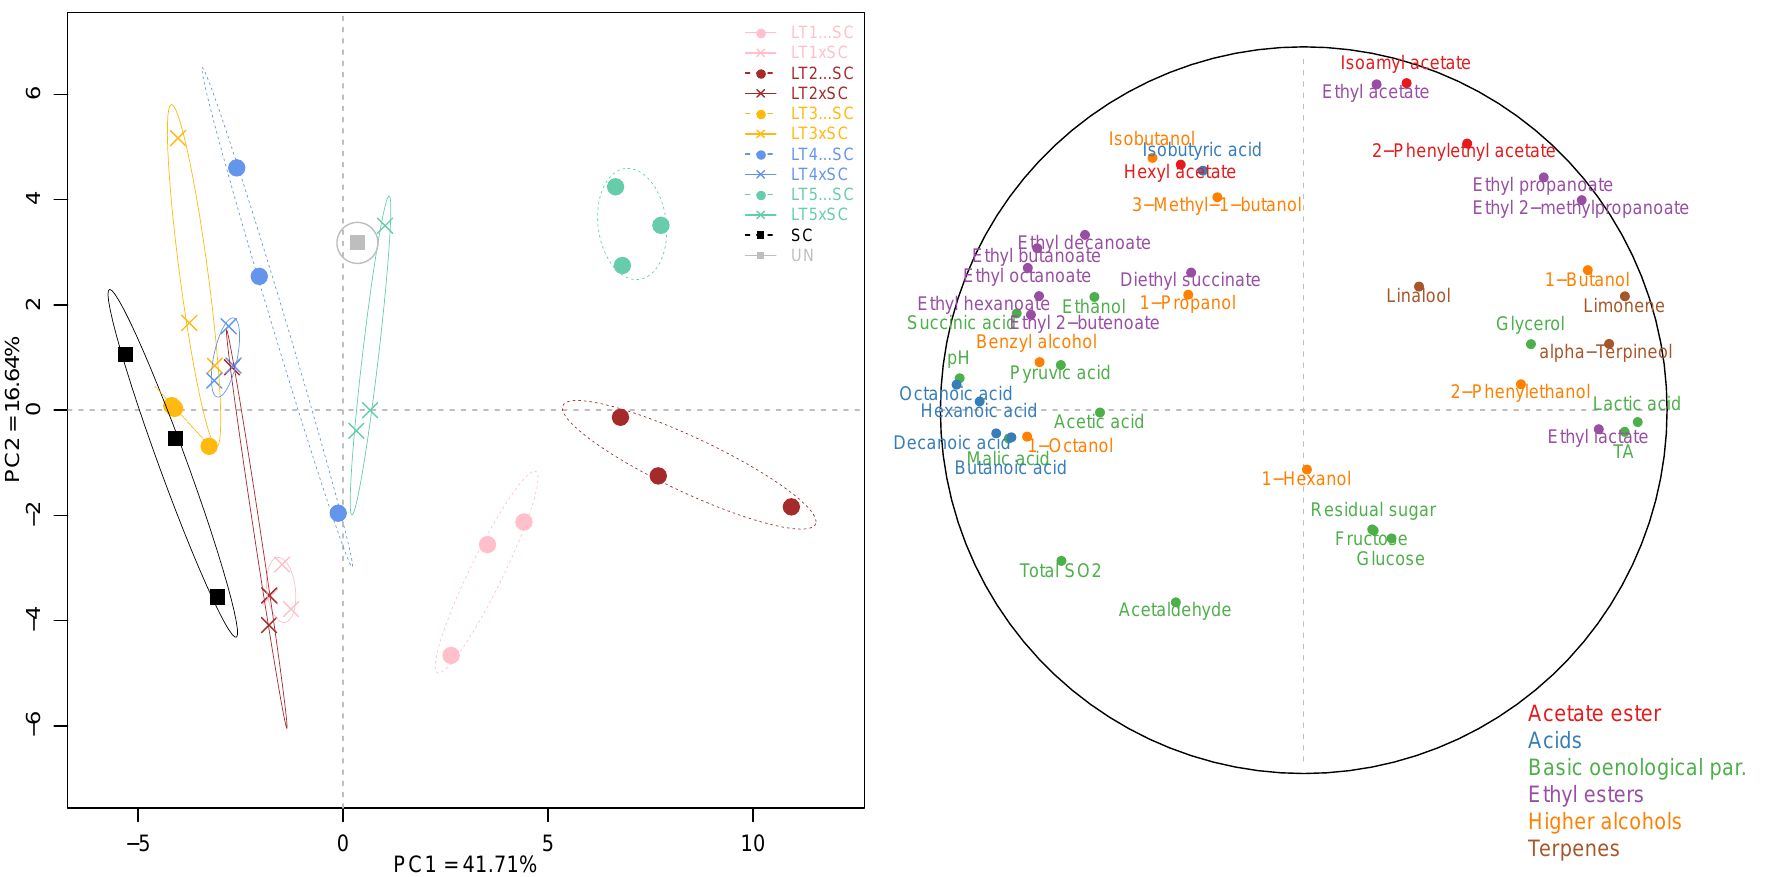
Figure 4. Principal component analysis of 43 chemical parameters in the experimental Viognier wines: yeast treatments ( left ) and correlation circle ( right ). The abbreviations and colour-coding of yeast treatments correspond to those in Figure